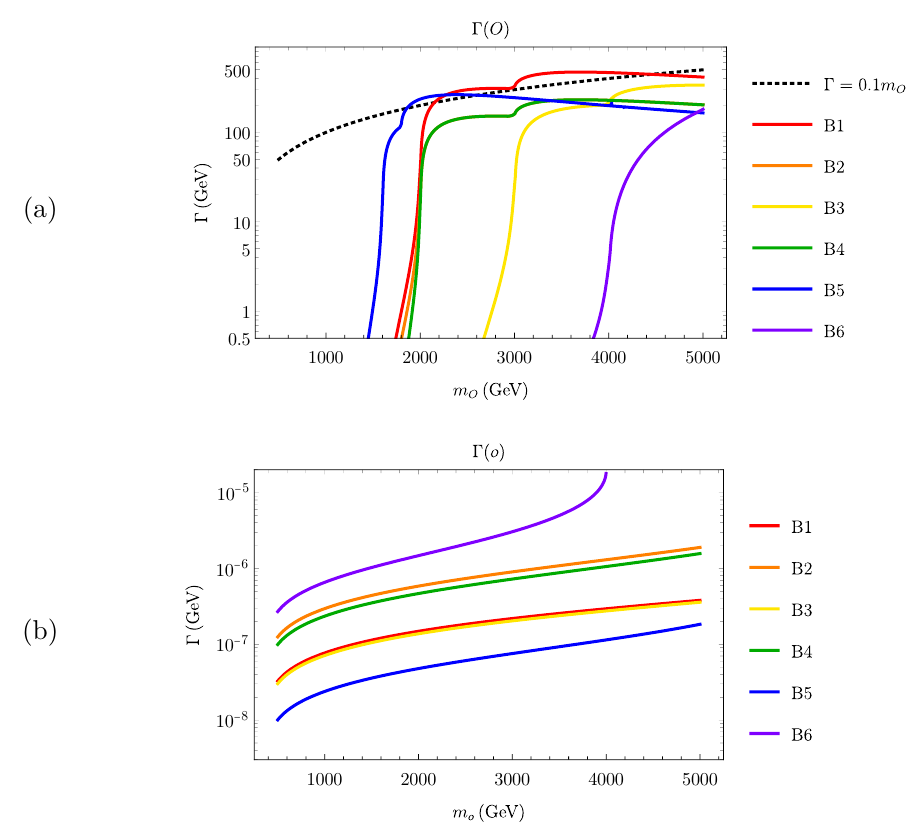
Figure 5. Total decay widths in benchmarks B1{B6 of (a) the scalar sgluon and (b) the pseu- doscalar. Scalar widths approach or exceed 10% of the particle’s mass above the squark de- cay